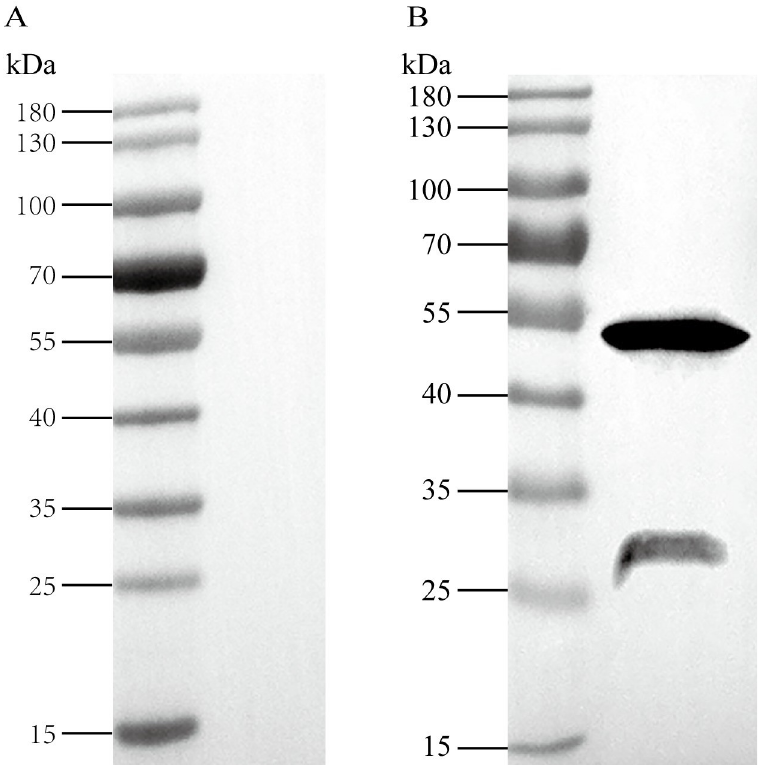
Fig 2. Identification of native SjCB2. Protein extracts of S . japonicum cercariae were resolved by SDS-PAGE, blotted onto PVDF membrane, and detected by pre-immune rabbit IgG (A) or anti-rSjCB2 IgG (B).